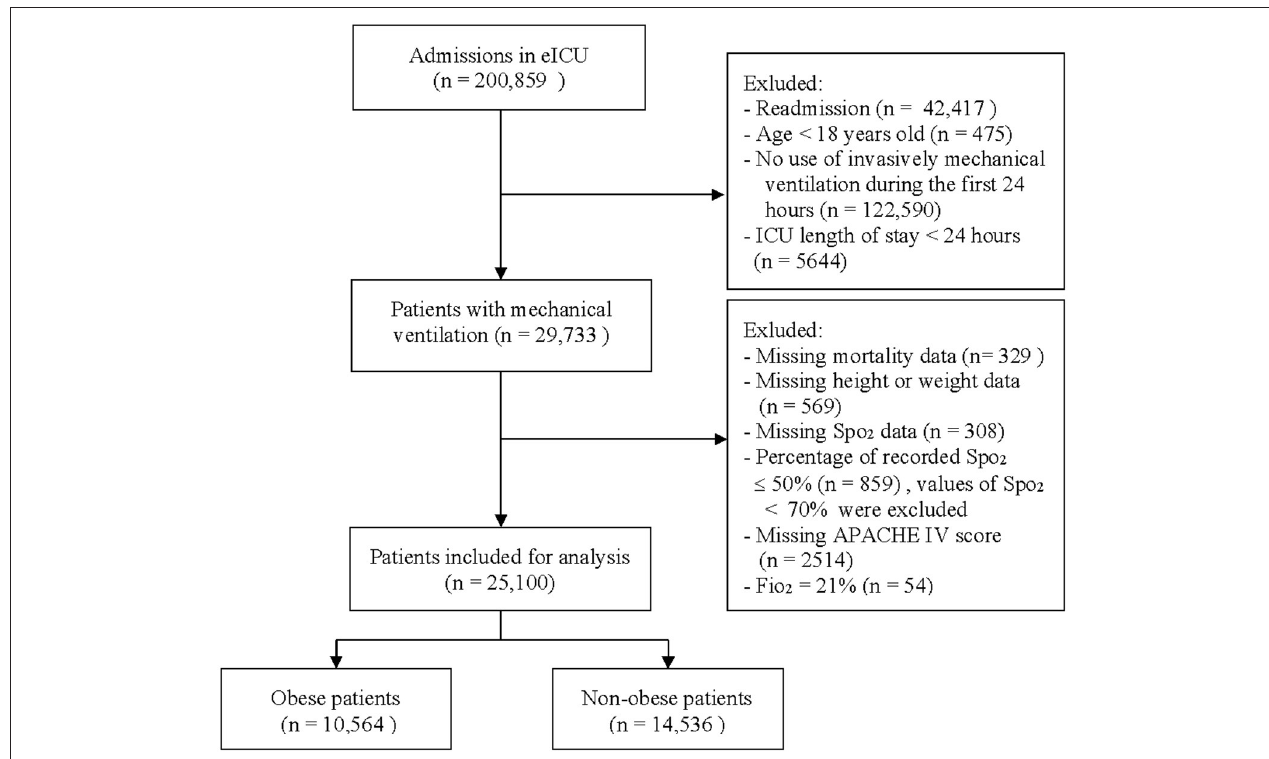
FIGURE 1 | Flow chart of subject selection. eICU, telehealth intensive care unit; Spo 2 , peripheral oxygen saturation; Fio 2 , fraction of inspiration